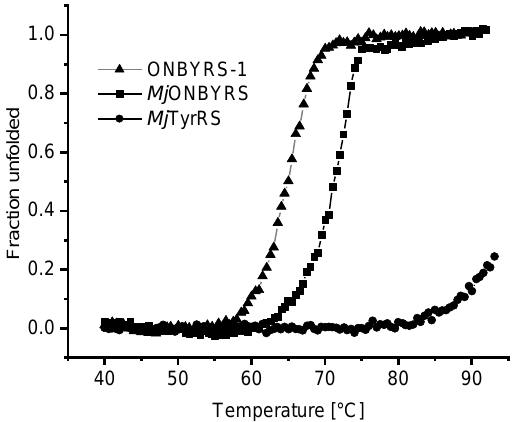
Figure 7. Stability of Mj TyrRS wild type and derived aaRS variants measured by circular dichroism (CD) spectroscopy. Thermal protein denaturation was performed in phosphate buffer while recording the CD signal at 222 nm. Due to the high thermostability of the wild type enzyme, the corresponding T m value (>95 °C) cannot be accurately determined in the chosen setup. Calculated T m values for ONBYRS-1 and Mj ONBYRS are 64.8 °C and 71.0 °C, respectively.